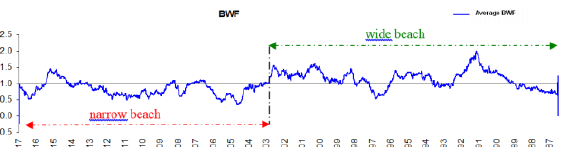
Figure 5. Average BWF value in the period of 1964-2004 in the examined part of Baltic Sea